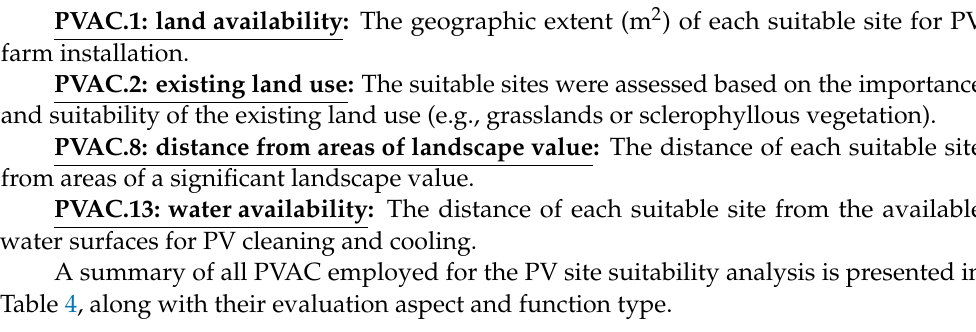
Table 4. Summary of the PVAC applied in Phase 4 of the proposed framework. PVAC